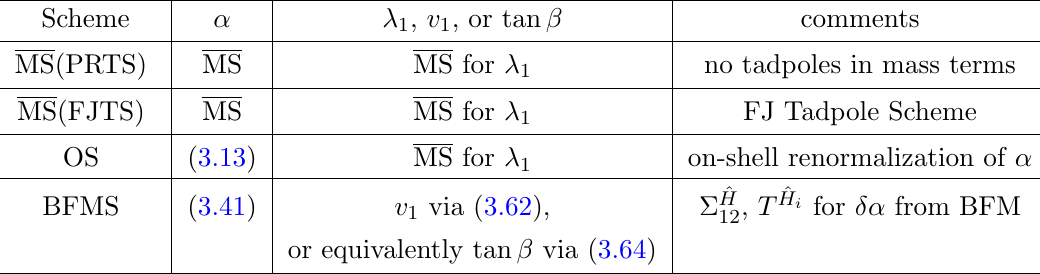
Table 1 . Summary of renormalization schemes used in the HSESM.